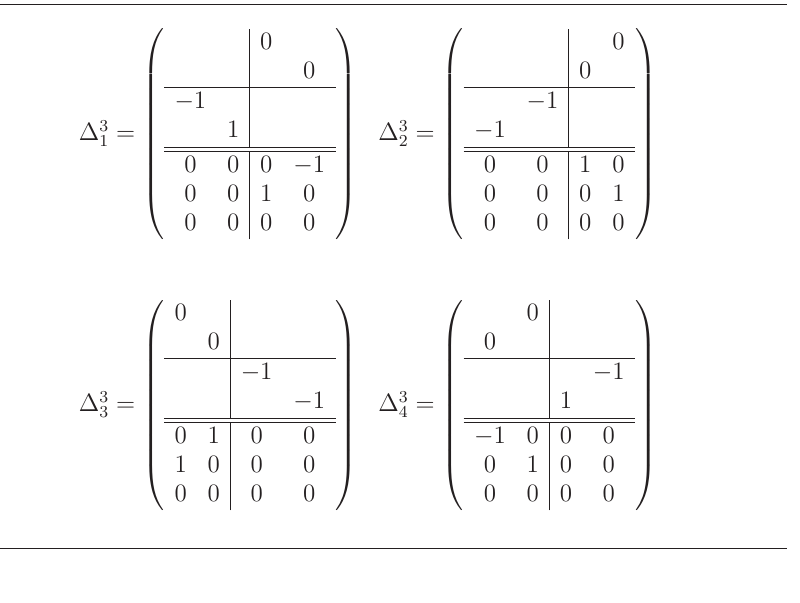
Table 10: The 3-sector space-like down matrices for the Maxwell field-strength